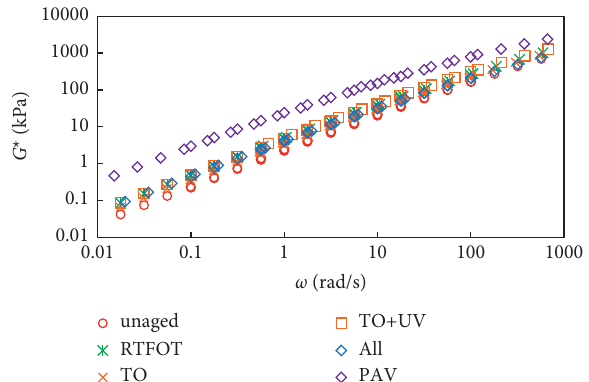
Figure 4: Master curve of complex modulus of asphalt binder before and after